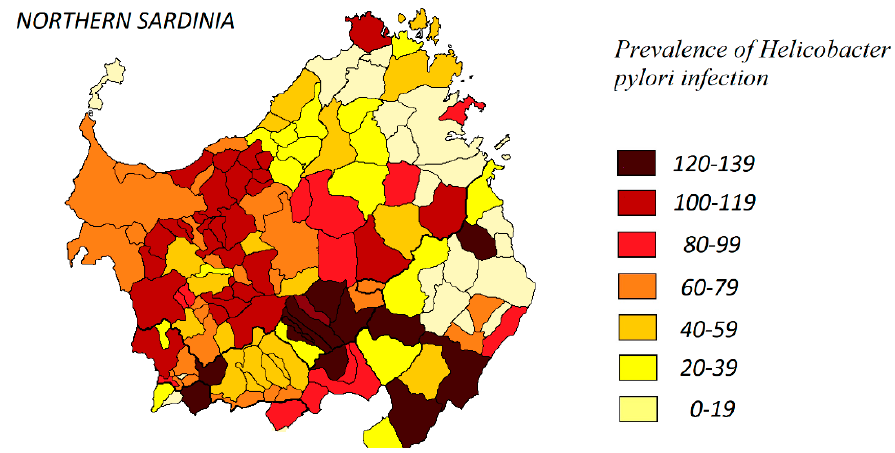
Figure 2. Distribution of H. pylori infection in Northern Sardinia according to the study findings.